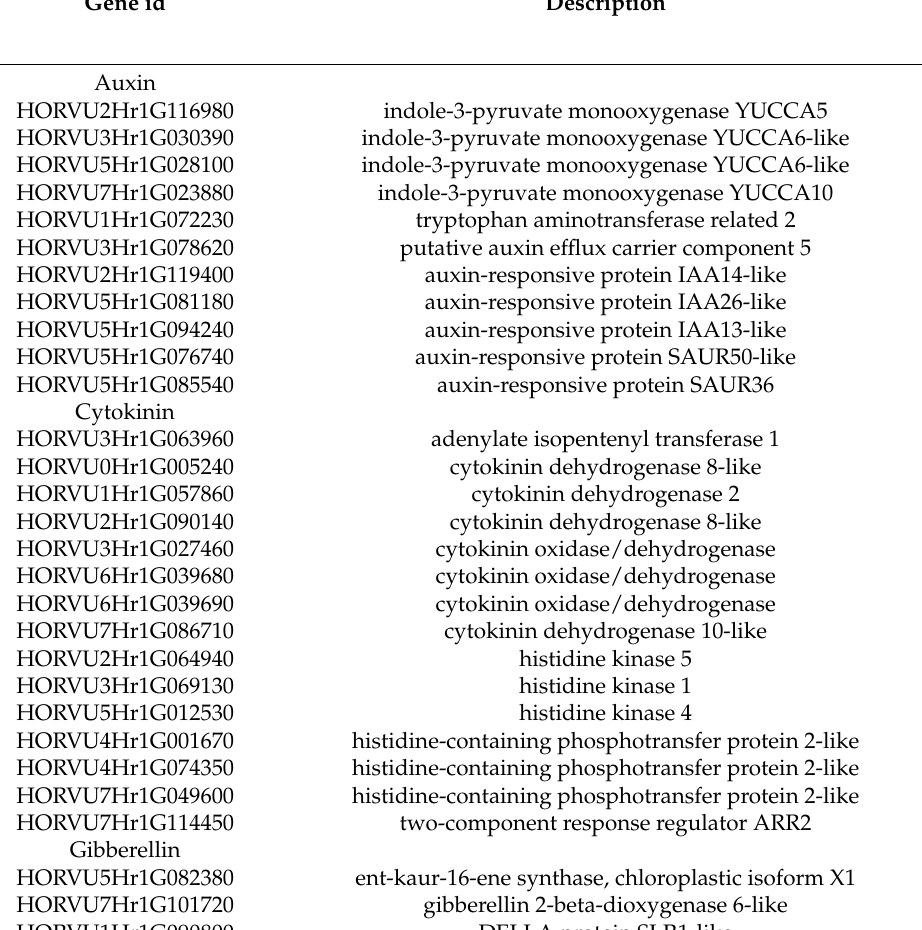
Table 1. Expression levels of phytohormone-related genes in callus of GP and ZU. Gene